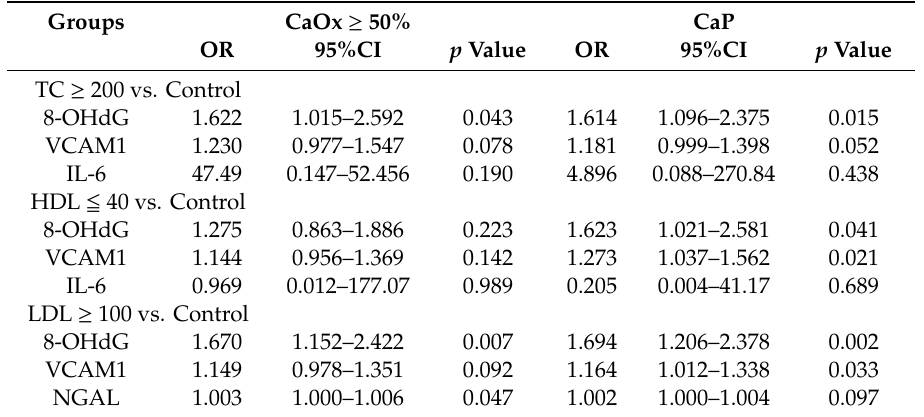
Figure 2. Serum markers of inflammation and oxidative stress compared to the controls in stone patients with CaOx and CaP, respectively. (The Nitro Tyrosine data was reduced 100X; IL-6 was magnified 10X, and neutrophil gelatinase associated lipocalin (NGAL) was reduced 100X from the original values in Figure 2 A , 2 B , and 2 C . ( A ), TC > 200, ( B ), HDL ≤ 40 , ( C ) LDL ≥ 100. ( D ). Correlation between serum 8-OHDG and VCAM1; ( E ). Correlation between serum 8-OHdG and IL-6; ( F ). Correlation between urinary Oxalate level and serum NGAL level. Table 5. Serum markers of inflammation with abnormal cholesterol levels compared to the controls, using a logistic regression (adjusted by age and sex).